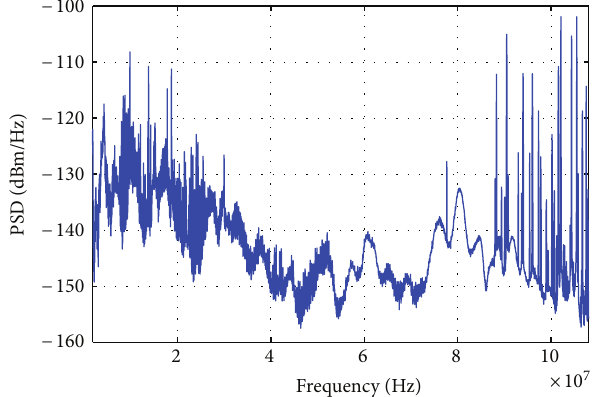
Figure 9: HomePlug AV2 measurement campaign. Example of noise measurement.